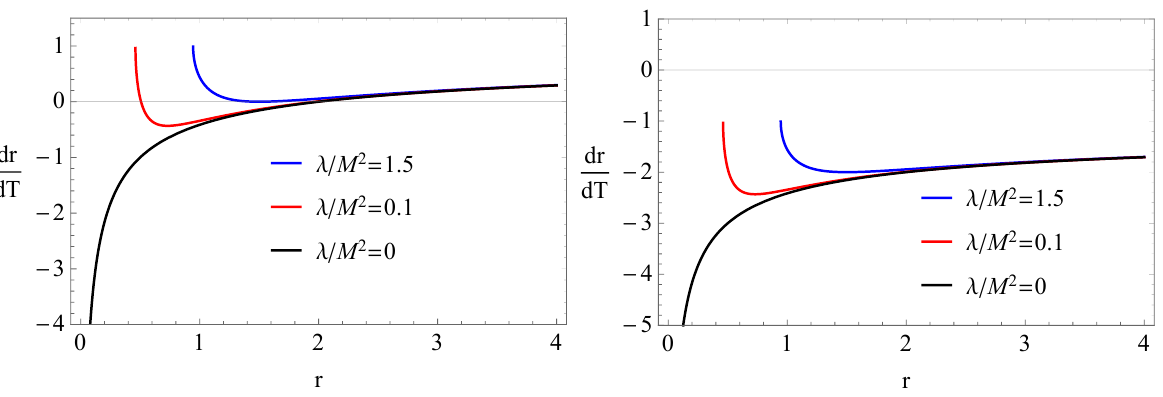
Figure 3. Left panel : The velocity of light observed in a freely falling frame for light moving inward. Right panel : The velocity of light observed in a freely falling frame for light moving outward. We have set M =